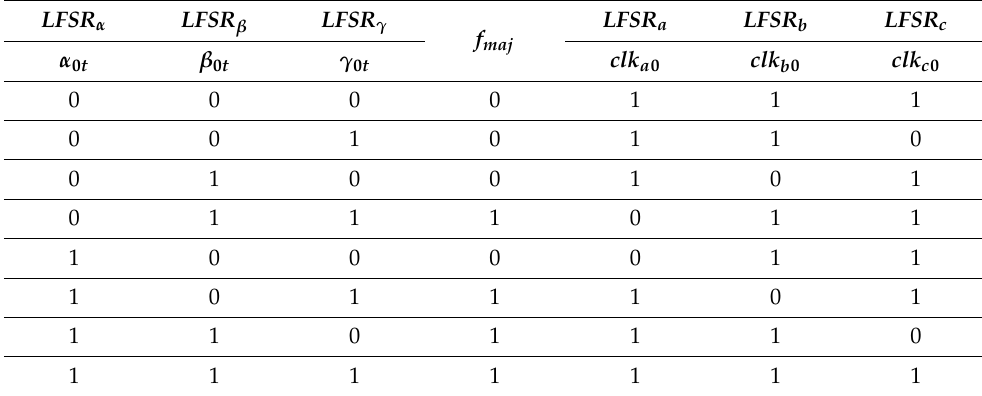
Table 2. Clocking condition under m 0 = 0.